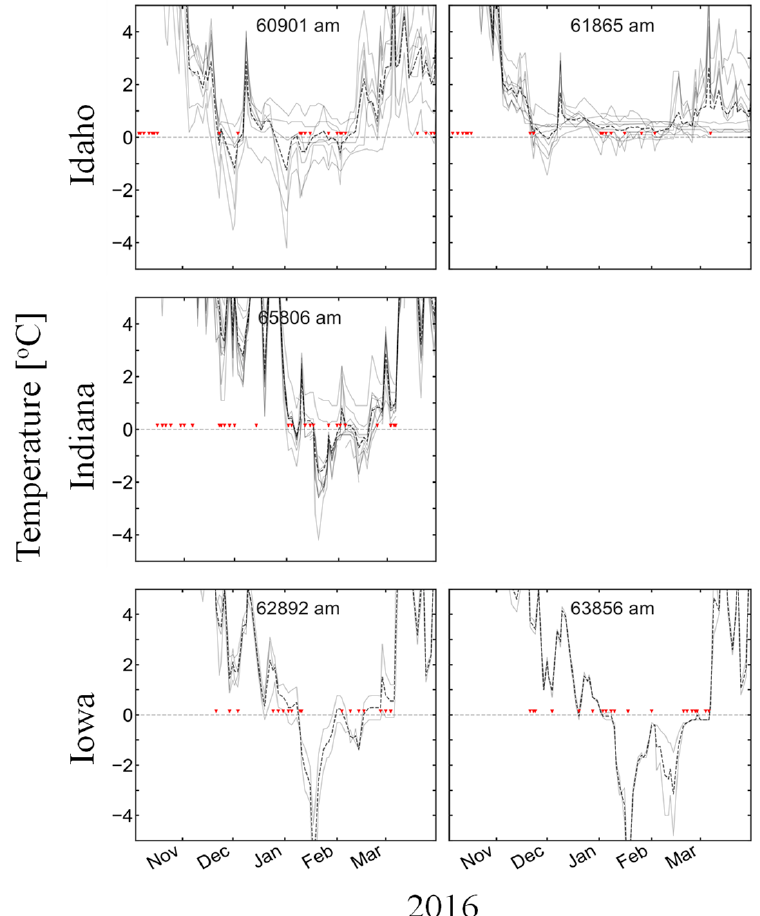
Figure 9. Temperature time series of stations (gray) with SMAP retrieval errors indicated (red marker). The black dashed line shows the site average 0–5 cm soil temperature.